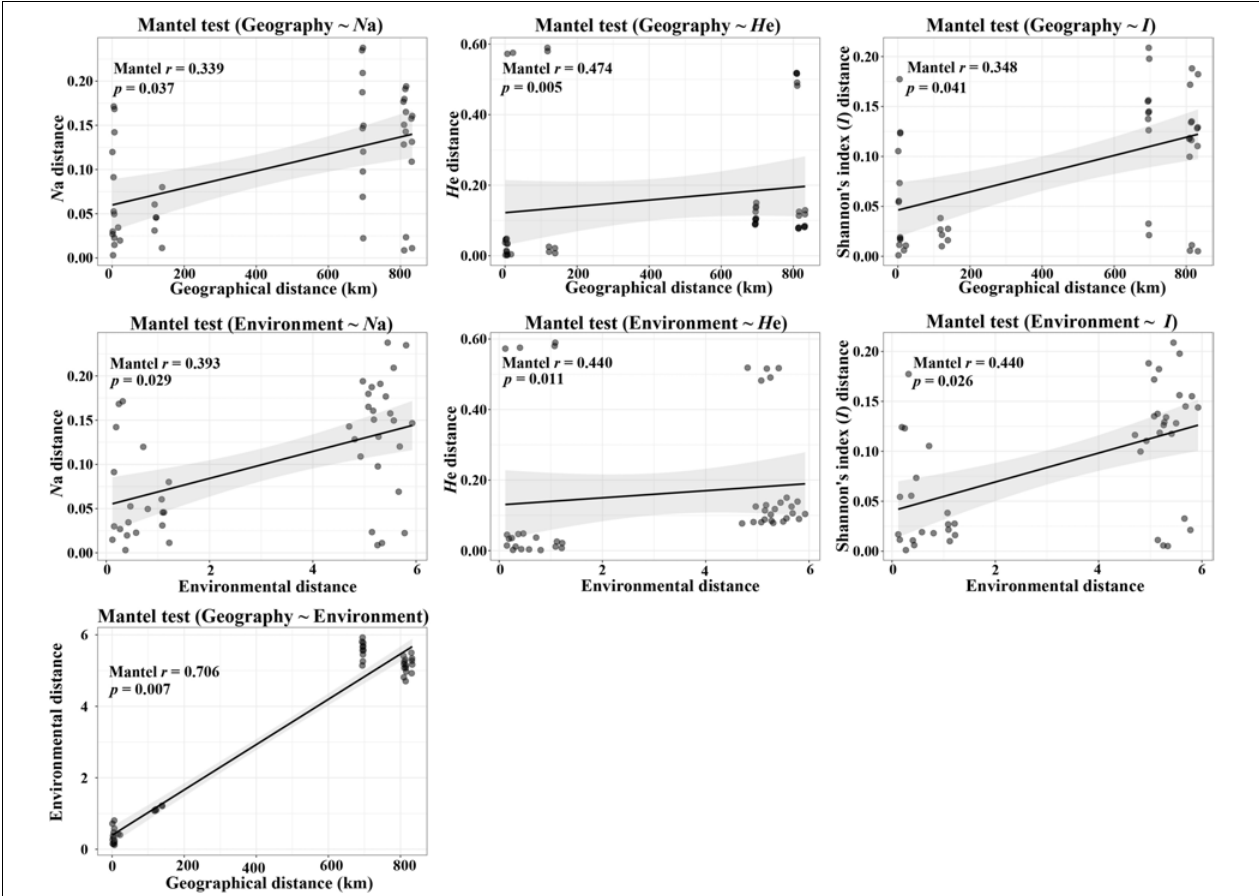
FIGURE 4 | Plot of Mantel tests for the correlation between genetic diversity parameter (Bray–Curtis distance) and explanatory distances (geographic and environmental distance) using Spearman’s